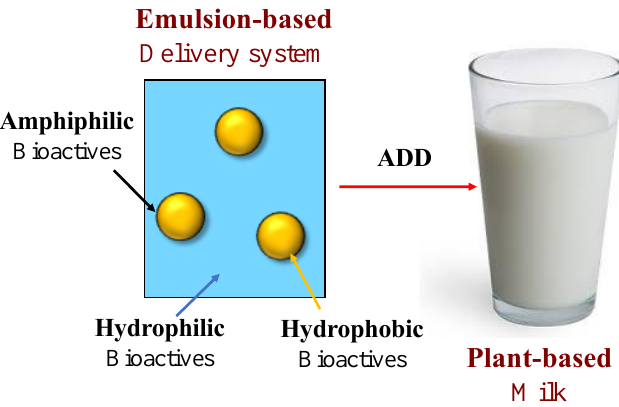
Figure 6. Bioactive agents with different polarities can be added to plant-based milks via emulsion-based delivery systems.